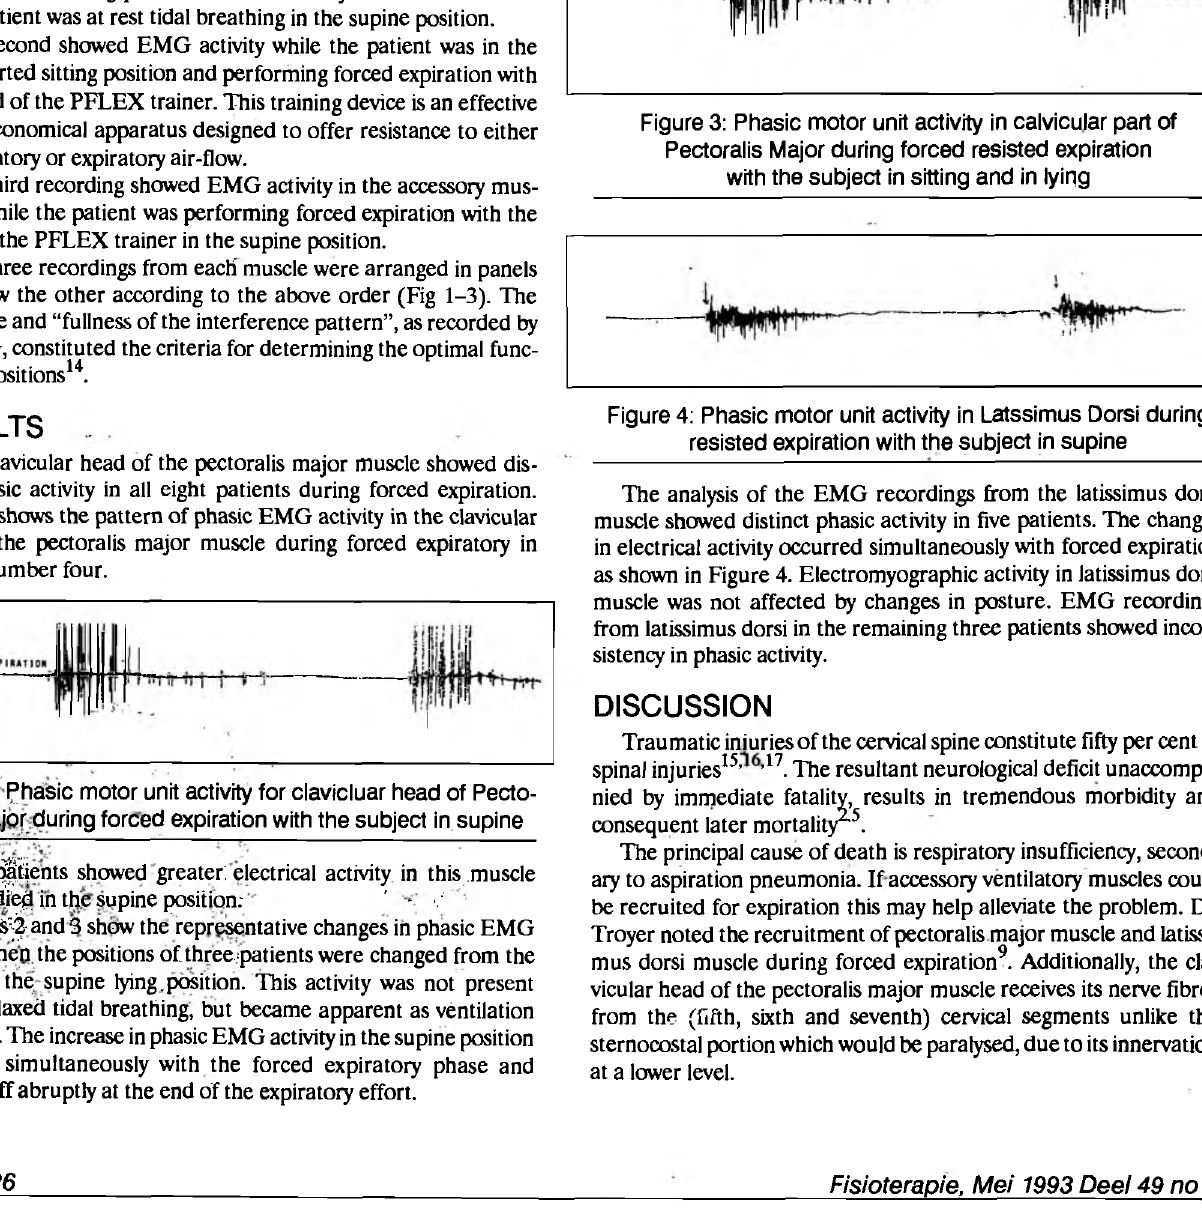
Figure 2: Phasic motor unit activity in clavicular part of Pectoralis Major during forced resisted expiration with the subject in sitting and in supine